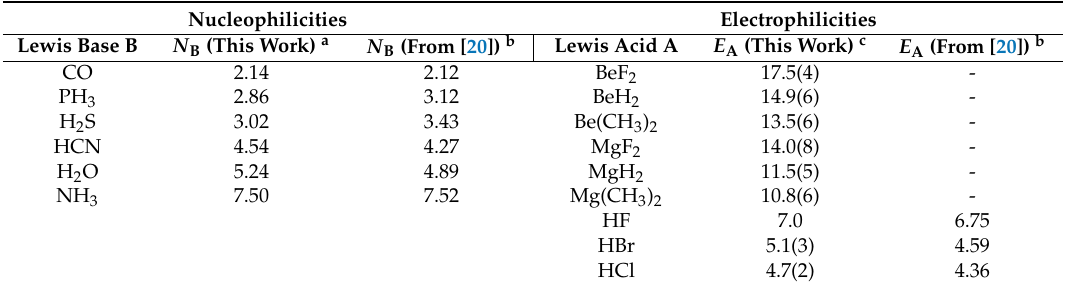
Table 3. Nucleophilicities of six Lewis bases, B, and electrophilicities of nine Lewis acids, A. Nucleophilicities Electrophilicities Lewis Base B